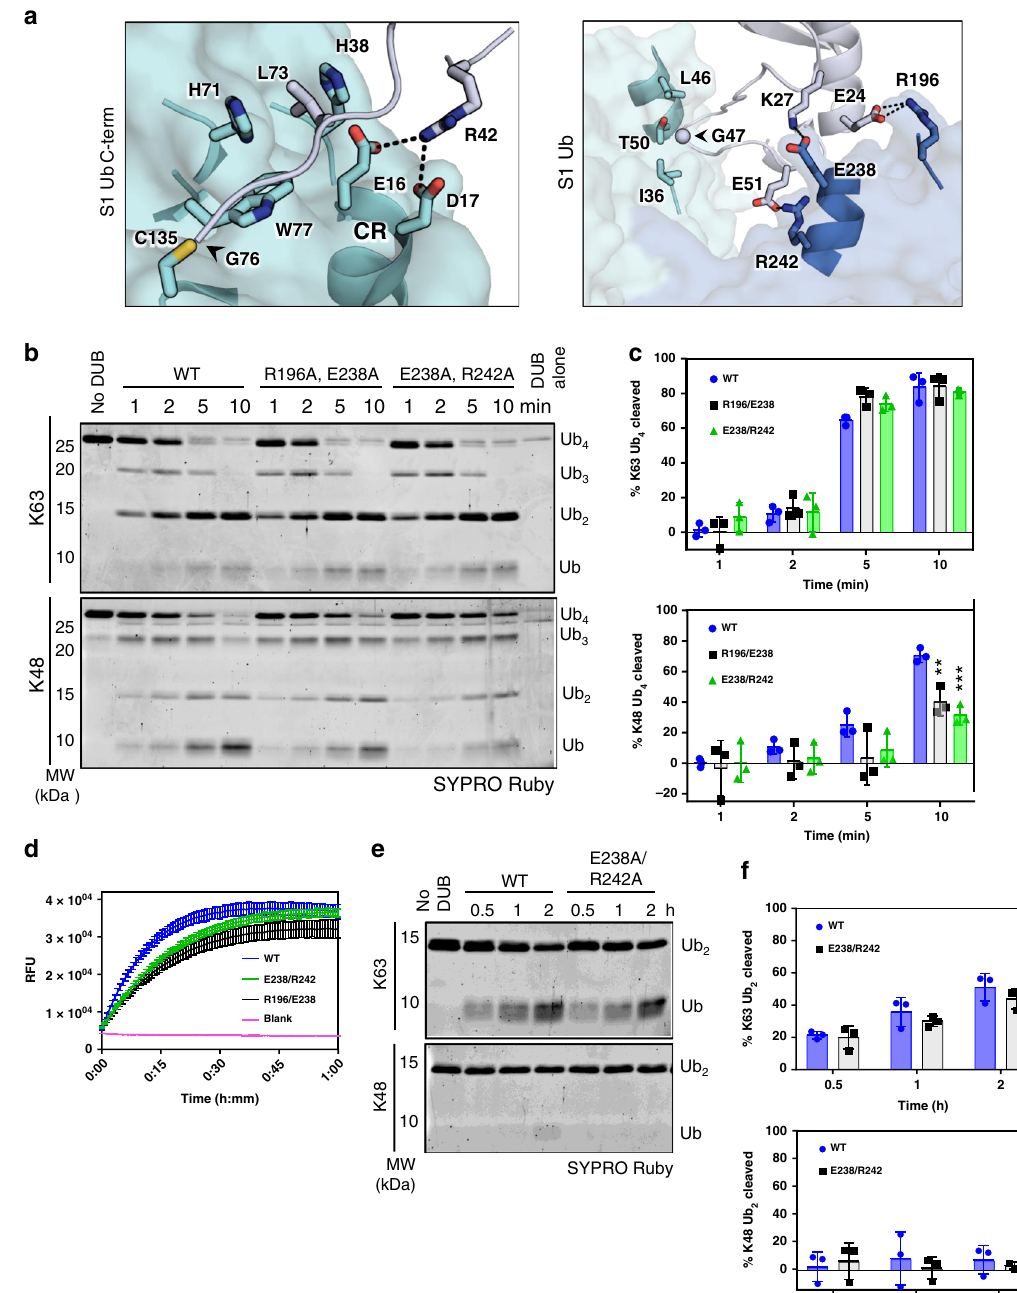
Fig. 4 Interactions with OtDUB VR-1 are required for ef fi cient K48-chain cleavage. a Two views of S1 ubiquitin (gray) in the active site of OtDUB (cyan). Left: C terminus of S1 ubiquitin in an elongated conformation with interacting residues shown as sticks. Right: VR-2 (cyan) and VR-1 (slate) sandwich S1 ubiquitin using hydrophobic and electrostatic interactions, respectively. b In vitro cleavage assays of tetra-ubiquitin chains (2 µ M) by WT and mutants of OtDUB 1 – 259 (50 nM). Source data are provided as a Source Data fi le. c Quanti fi cation of Ub 4 cleavage rates using data, exempli fi ed by b , from three independent experiments; mean and SD are shown. Source data are provided as a Source Data fi le. Unpaired, two-tailed t tests were performed for comparisons between OtDUB 1 – 259 WT and VR-1 mutants for each condition and time point (** p < 0.005, *** p < 0.0005). d Ub-AMC-cleavage assays comparing the activities of WT, R196A/E238A and E238A/R242A OtDUB 1 – 259 . Ub-AMC (400 nM) was incubated alone (Blank) or with 350 pM of the indicated OtDUB. Lines are the average of technical triplicates with SD bars at each 40-s interval. e K63 and K48 di-ubiquitin cleavage assays utilizing WT and E238A/R242A OtDUB 1 – 259 . Di-ubiquitin (1 µ M) was incubated in the presence or absence of the indicated OtDUB (0.5 µ M) for 0.5, 1, and 2 h. Source data are provided as a Source Data fi le. f Quanti fi cation of Ub 2 cleavage rates using data, exempli fi ed by e , from three independent experiments; mean with SD values are shown. Source data are provided as a Source Data fi